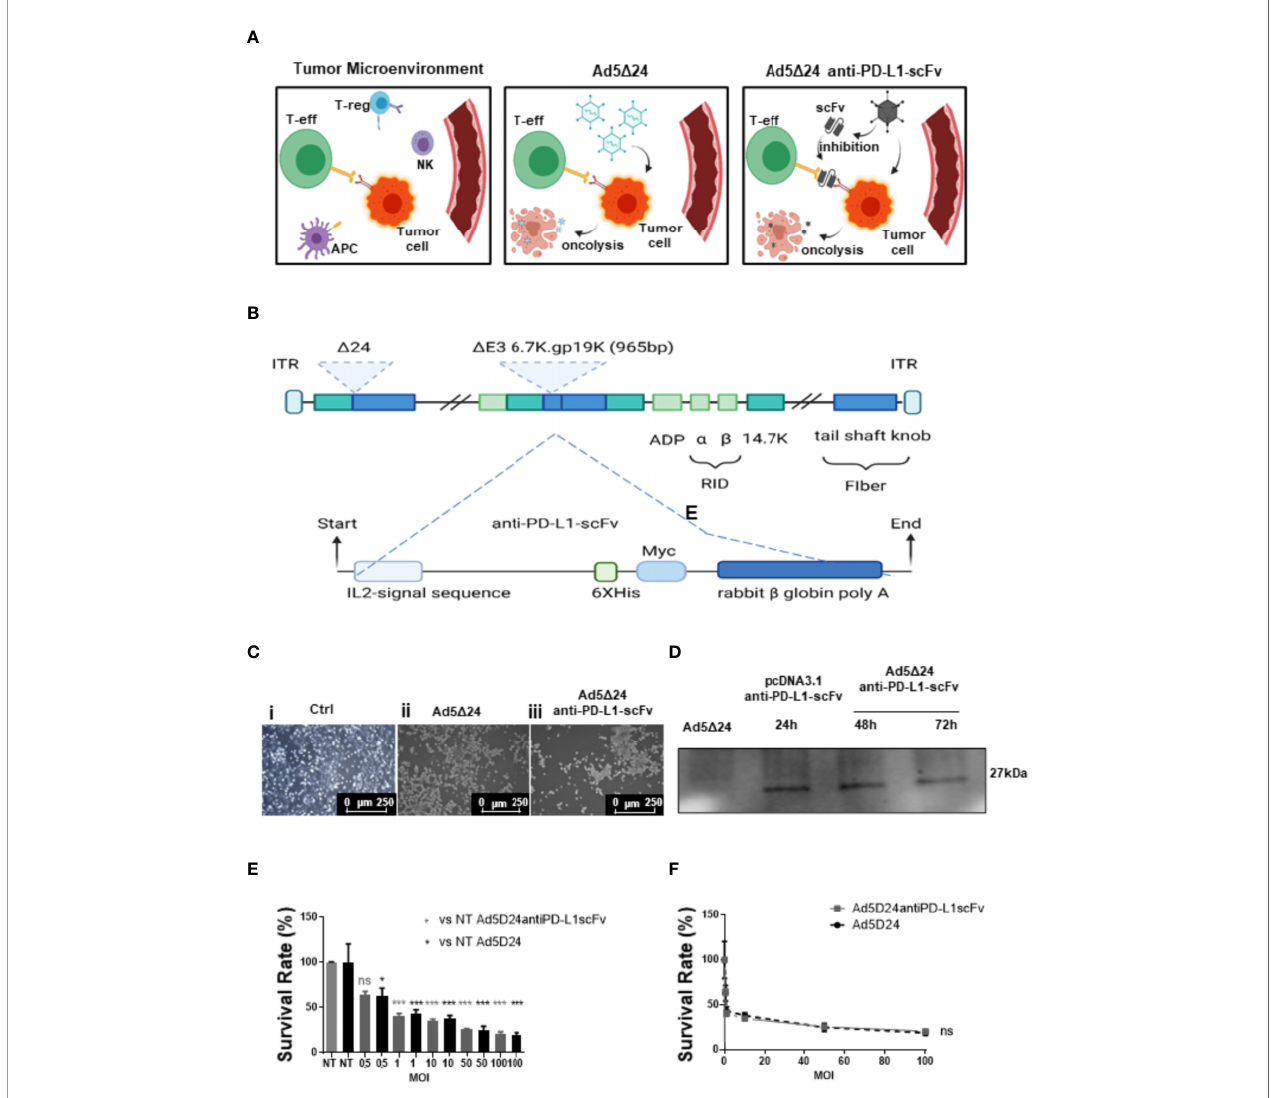
FIGURE 1 | Design and characterization of a novel Ad5delta24-anti-PD-L1-scFv. (A) The interaction between PD-L1 on the surface of tumor cells and PD-1 on the surface of T cells induces as a result the immune escape (left panel). The injection of Ad5 D 24 into TME, results in a potent lytic effect on tumor cells, leading to a tumor- speci fi c T cells response (central panel). The injection of Ad5 D 24-anti-PD-L1-scFv into TME, induces not only a potent lytic effect on tumor cells, due to Ov. Ads, but also, inhibit the interaction between PD-L1 and PD-1 through the expression of an scFv, resulting in a failure of immune escape (right panel). Regulatory T cells (Tregs), natural killer (NK) cells, tumor cells, and effector T (Teff) cells in the tumor microenvironment (TME). (B) A schematic representation of oncolytic adenovirus serotype 5 (Ad5) DNA viral backbone containing a deletion of 24 bp ( D 24 or D24) in the Rentinoblastoma (Rb) binding constant region 2 of E1 gene. Dashed line indicate the insertion site of a nucleic acid sequence encoding a single chain fragment variable (scFv) anti-PD-L1, in the place of the deleted gp 19k/6 in the adenoviral E3 region. (C) A549 cells were infected with 50MOI of Ad5 D 24 (ii) or Ad5 D 24-anti-PD-L1-scFv (iii). Images show that compared to control cells (i) at 48hrs post-infection a potent lytic effect was noted con fi rming that the remodeling of Ad5delta24 DNA does not interfere with its oncolytic action. (D) To test the scFv production A549 cells were infected with 500 MOI of Ad5 D 24-anti-PD-L1-scFv, and the media was collected at 48 and 72 h to test the presence of scFv by using an anti-Hys-tag as primary antibody. Collected media from A549 cells infected with Ad5 D 24 were used as a negative control, while media from A549 cells transfected with pcDNA 3.1+ scFv anti-PD-L1 at 24 h was used as positive control. A band of 27 kD was detected in the media of infected or transfected cells while was absent in the negative control. (E) A549 were infected with increasing MOI of Ad5 D 24 (in black) or Ad5delta24-anti-PD-L1-scFv (in gray) and cell count was performed at 48hrs post-infection. The graphs show the survival rate expressed in the percentage of the cell still alive and compared to the uninfected control. The data were analyzed with GraphPad Prism version 5.02 through One-way analysis of variance. The signi fi cance was evaluated with Turkey ’ s Multiple Comparison Test comparing each condition to the uninfected control. In the graph, SEM is reported for each column. (F) Comparison of survival rate in A549 infected with different MOI of Ad5 D 24 or Ad5delta24-anti-PD-L1-scFv at 48 h post-infection. The graphics were obtained through GraphPad Prism 5.02 version. * ≤ 0.05, *** ≤ 0.001 and ns, not signi fi